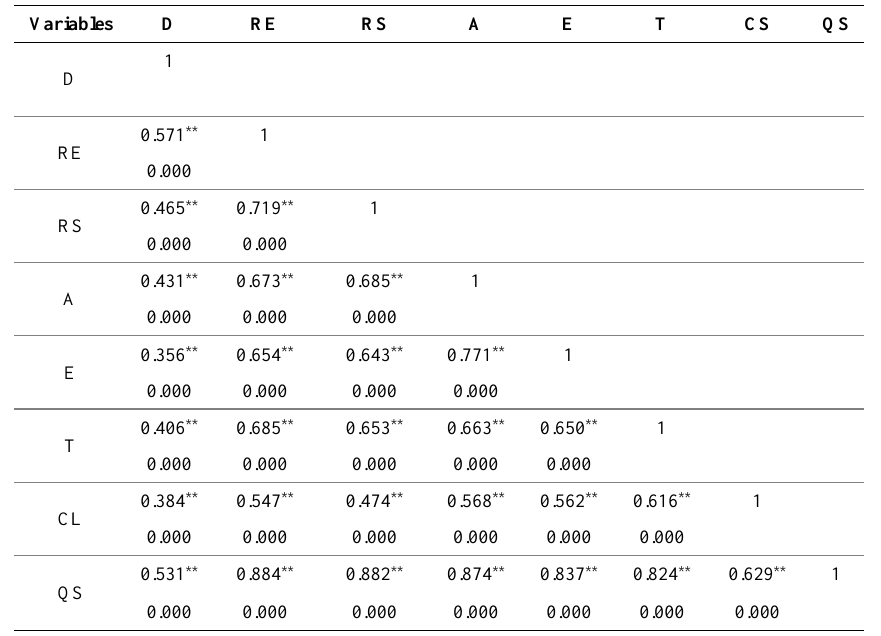
Table 4. Correlation matrix